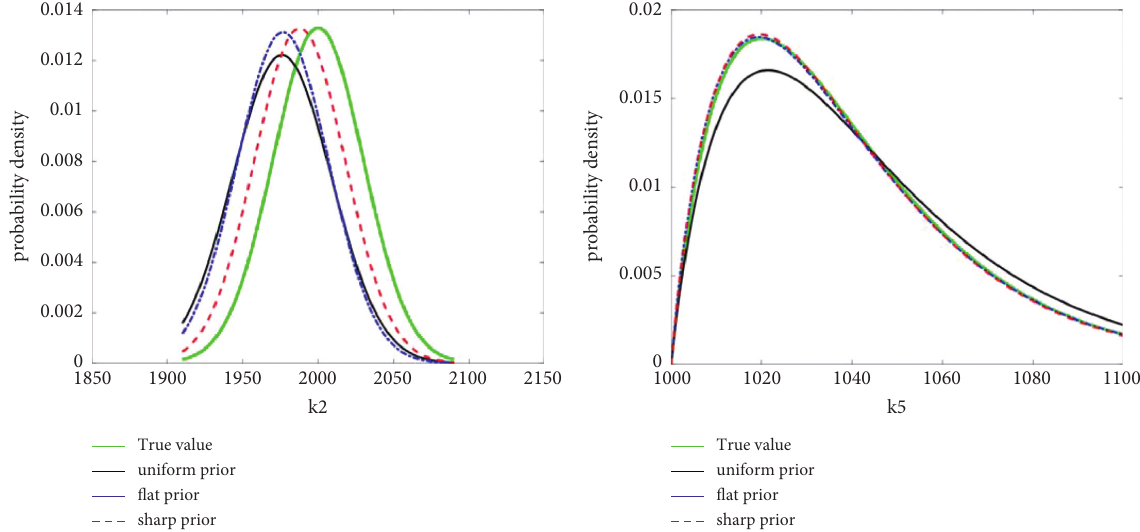
Figure 11: Identification results of PDFs for spring stiffness according to different priors.